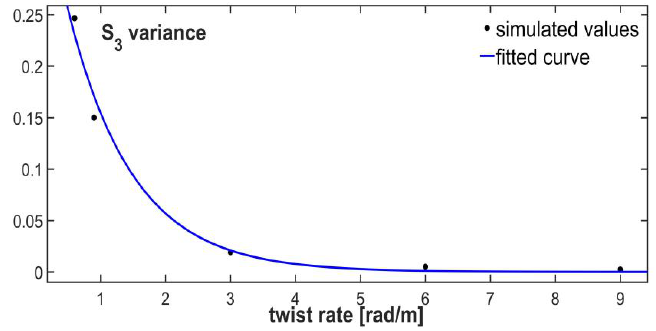
Figure 7. S 3 variance versus the twist rate.